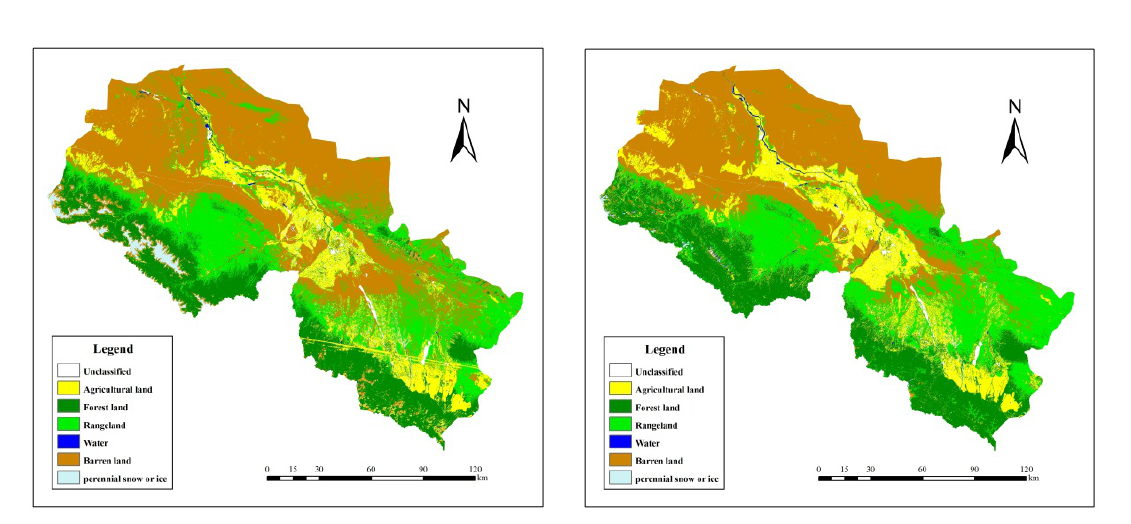
Figure 2. The LULC maps of the middle reach of the HRB for 2000 (left) and 2009